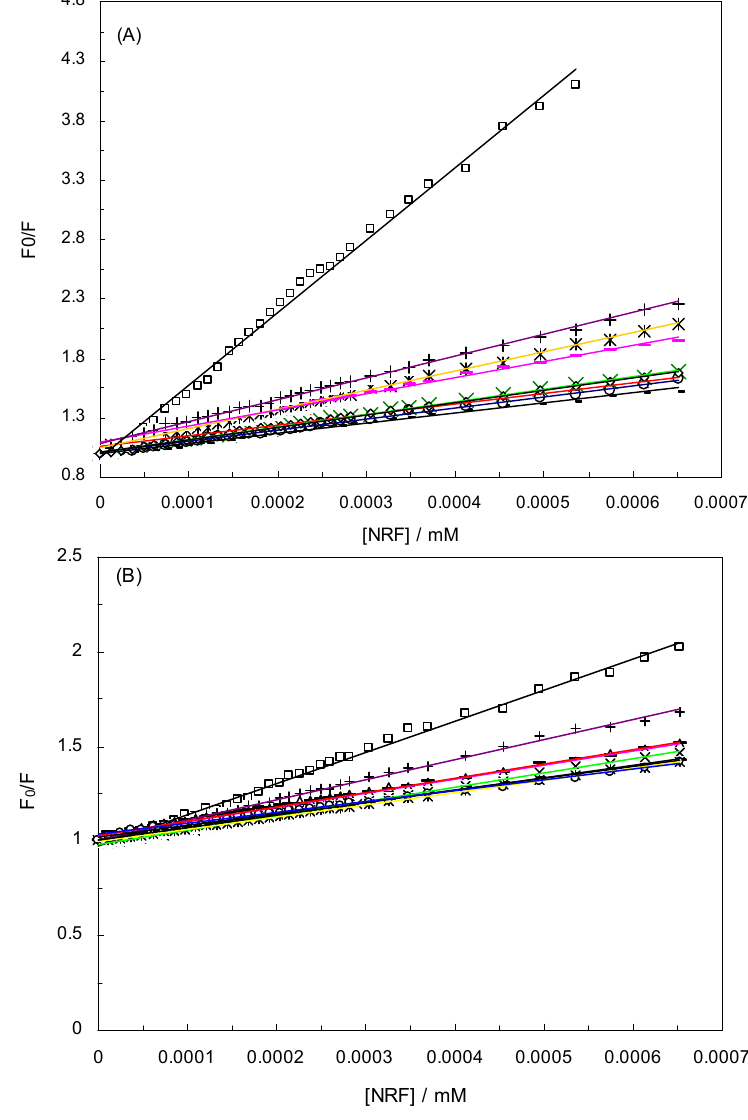
Figure 2. Stern-Volmer plots for the HSA-NRF systems in the presence and absence of EMFs. T = 298 K; pH 7.40, HSA-NRF ( □ ), 100 Hz/2.4 mT ( ◊ ), 100 Hz/6.4 mT ( ∆